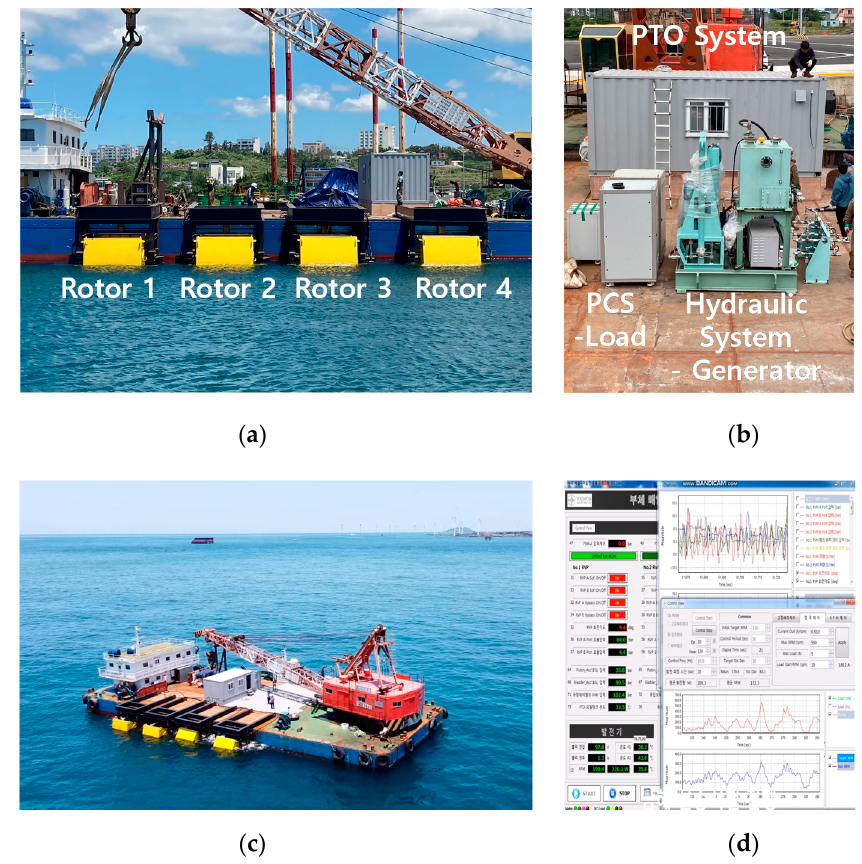
Figure 26. Actual FWEC sea test photos: ( a ) rotors, ( b ) PTO system (including the hydraulic system, generator, and PCS), ( c ) actual sea experiment, and ( d ) measurement and control system.